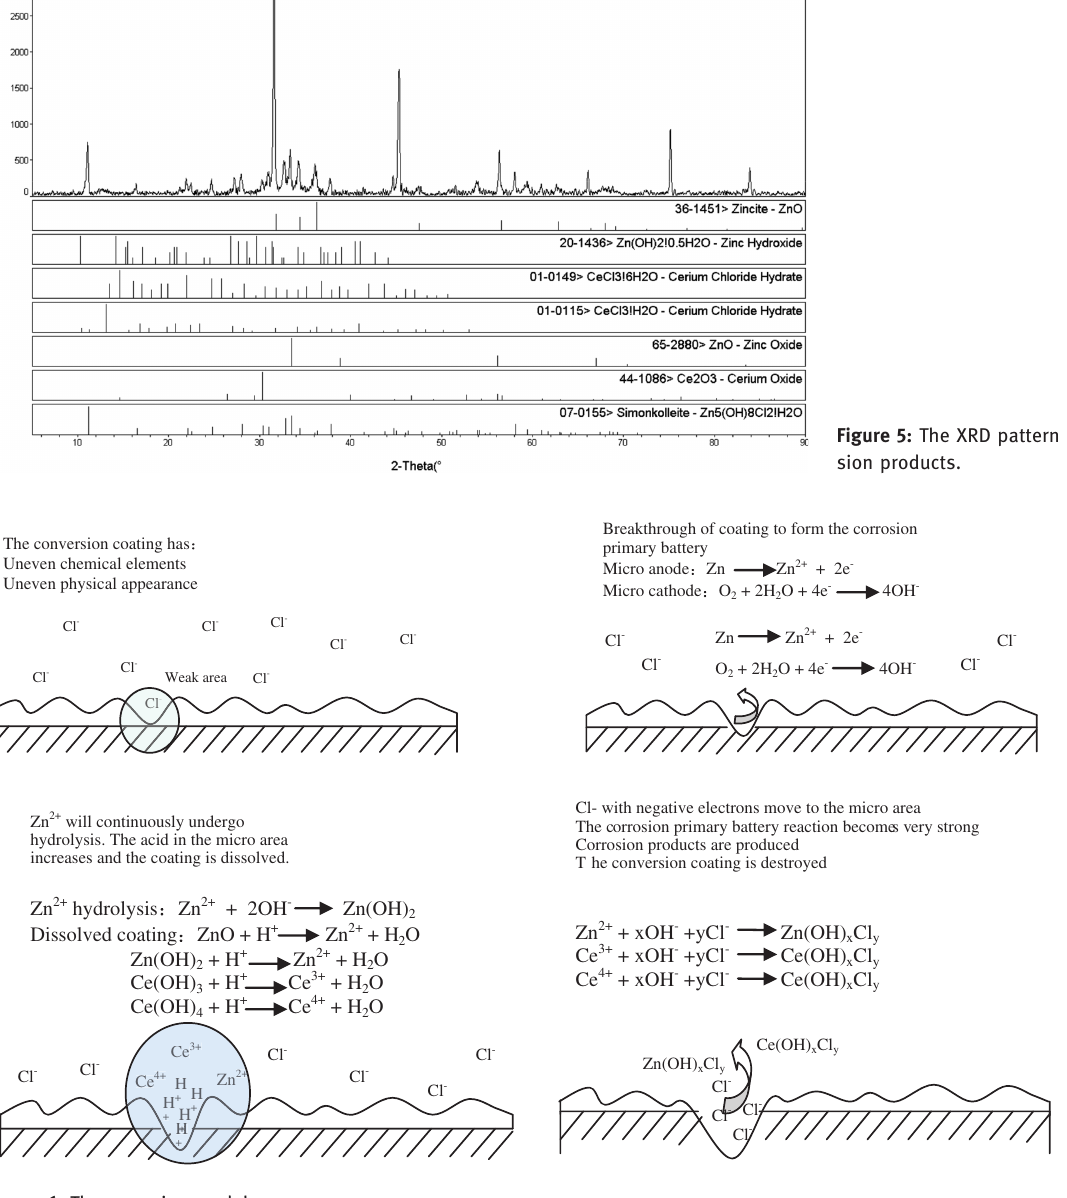
Figure 5: The XRD pattern of the corro- sion products.